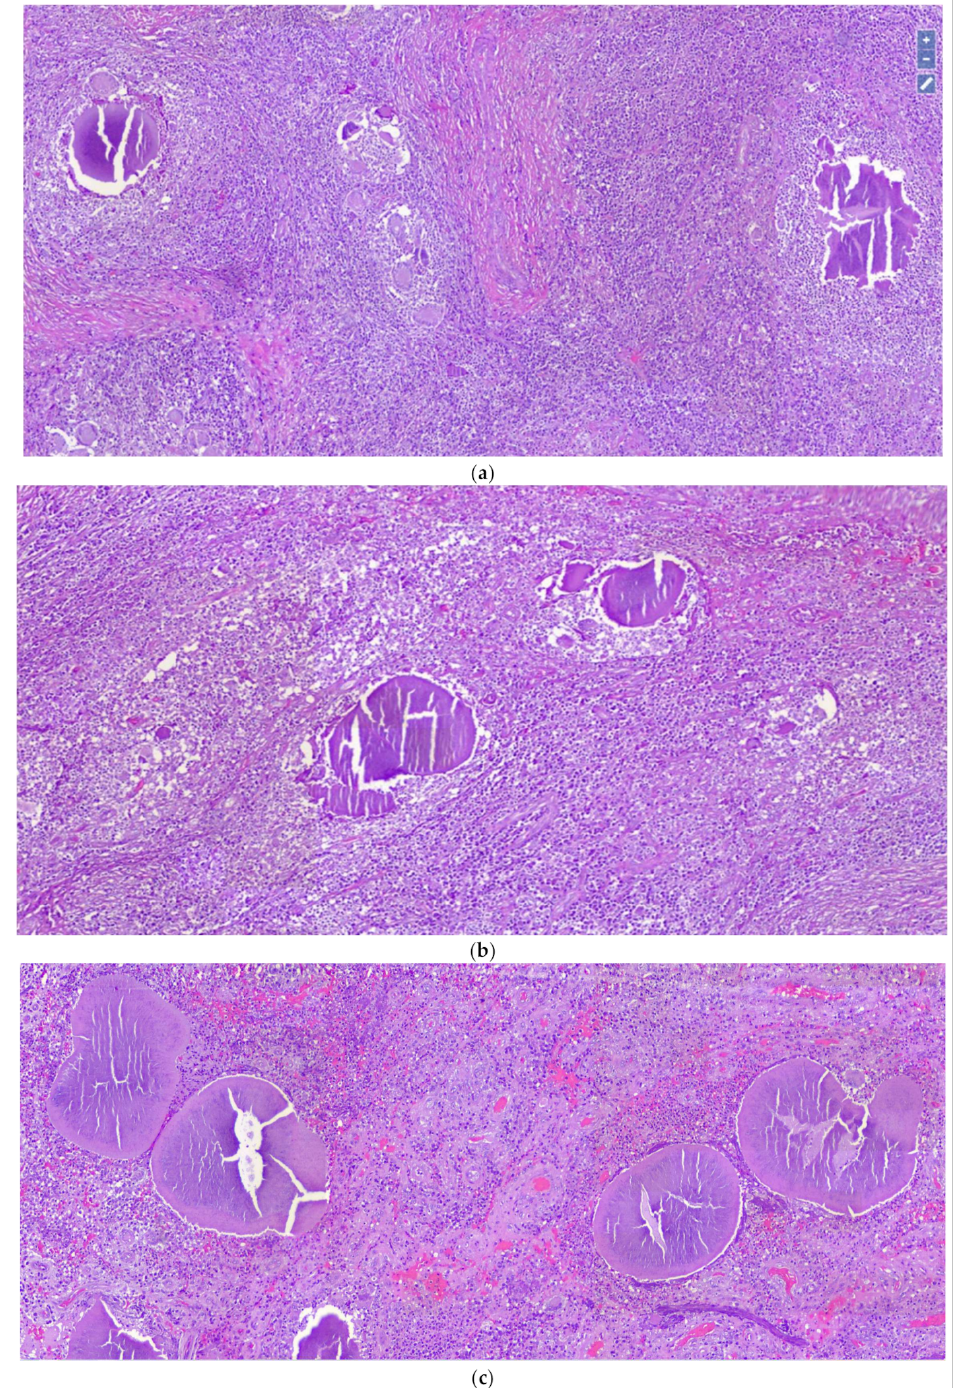
Figure 3. ( a ) Histological detail of the previous image (Hematoxylin-Eosin, Original Magnification: 10 × ). ( b , c ) Note large grains with dense thin filaments, often stains homogeneously, with transverse fracture lines (Hematoxylin-Eosin, Original Magnification: 20 ×